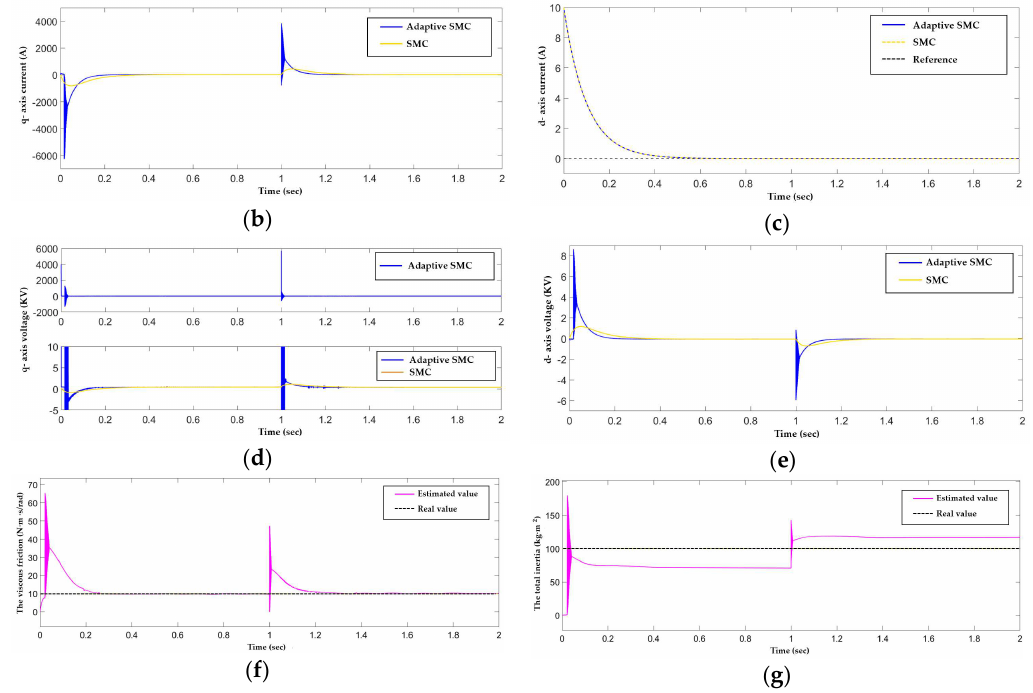
Figure 6. The Simulation results of the proposed adaptive SMC and SMC: ( a ) The rotor speed ω m and the reference rotor speed ω ∗ m ; ( b ) The q-axis current i q and reference value i ∗ q ; ( c ) The d-axis current i d and reference value i ref ; ( d ) The q-axis voltage input u q ; ( e ) The d-axis voltage input u d and reference value i ref ; ( f ) The real value of the total inertia J and estimator ˆ J ; ( g ) The real value of the viscous friction coefficient F and estimator ˆ F .